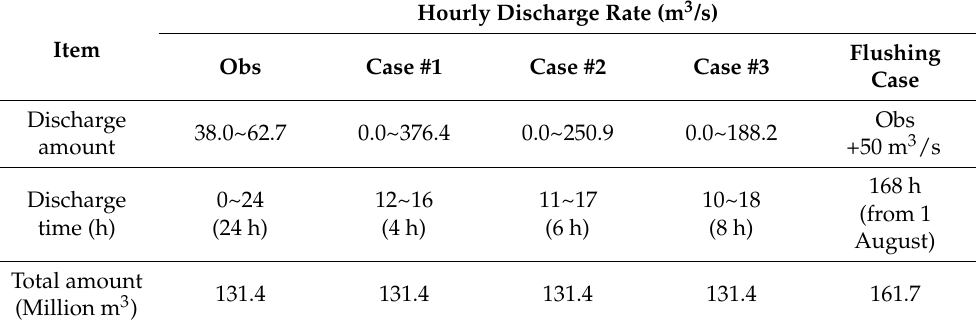
Table 4. Discharge conditions of oscillation and flushing